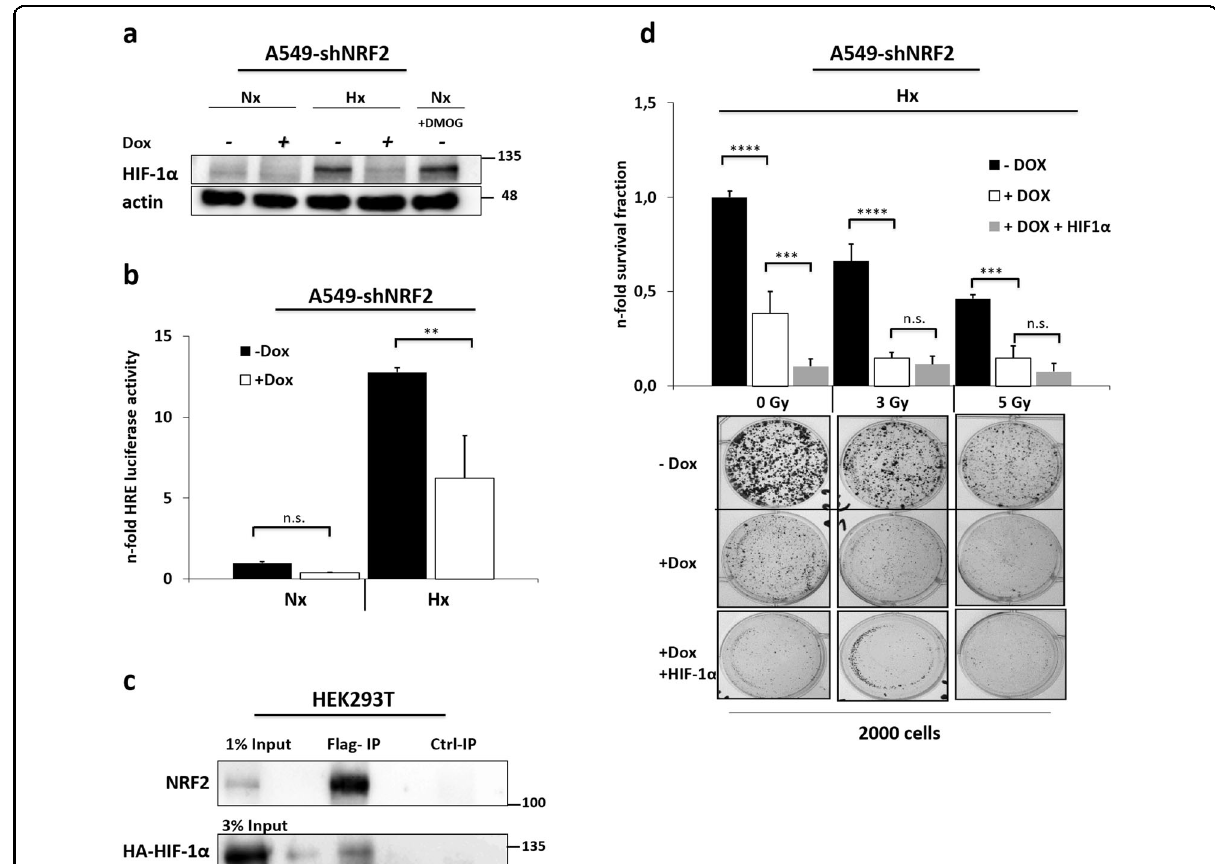
Fig. 4 NRF2 can interact with HIF-1 α and is essential for its activity. a After NRF2 KD for 48h and 16h in hypoxia, protein expression of HIF-1 α and loading control actin was monitored by western blotting. HIF stabilizing compound DMOG (1 mM) was used as a positive control for HIF-1 α in normoxia. b To detect transcriptional activity of HIF, a luciferase activity assay was performed in A549-shNRF2 cells transfected with pGLHIF1.3 43 , expressing fi re fl y luciferase downstream of three hypoxia-responsive elements (3x HRE), and pGL4.74 (renilla luciferase) for normalization. Seventy- two hours after KD induction and 16 h in normoxia or hypoxia, whole-cell lysates were used for measurement. c IP experiment to detect protein interaction of NRF2 and HIF-1 α . Plasmid Flag-NRF2 was co-transfected with vector p(HA)HIF1alpha (P402A,P564A), expressing a non-degradable/ oxygen-stable form of HIF-1 α , into HEK293T cells. NRF2 was pulled with an anti-Flag antibody (Flag-IP) and complex formation with HIF-1 α was determined by western blot analysis using anti-NRF2 and anti-HA (HIF-1 α ) antibodies. 1 – 3% of total cell lysate was loaded as input. d Clonogenic survival assay in A549-shNRF2 cells under hypoxic conditions after irradiation combined with HIF-1 α overexpression to compensate for KD of NRF2. Cells were transfected 24 h after KD induction with vector p(HA)HIF1 α